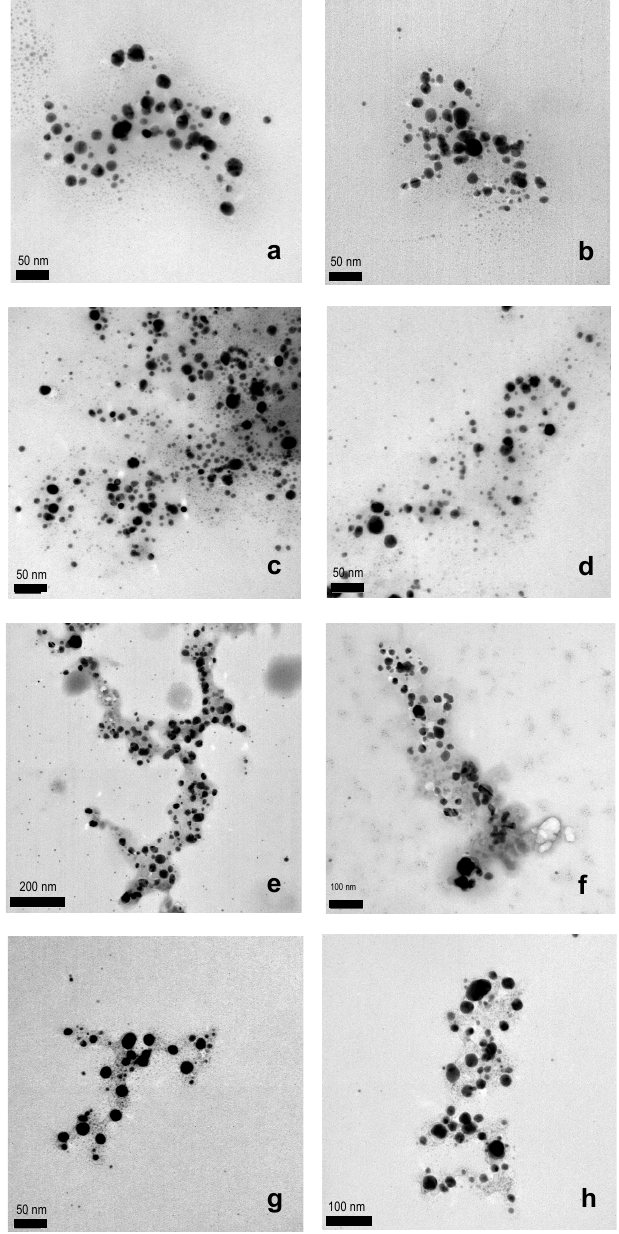
Figure 2. Representative TEM images of AgNPs synthesized by using WEOP of: ( a , b ) Bellis perennis petals, ( c , d ) Allium sativum peel, ( e , f ) Allium porrum green zone, and ( g , h ) Allium porrum white zone.